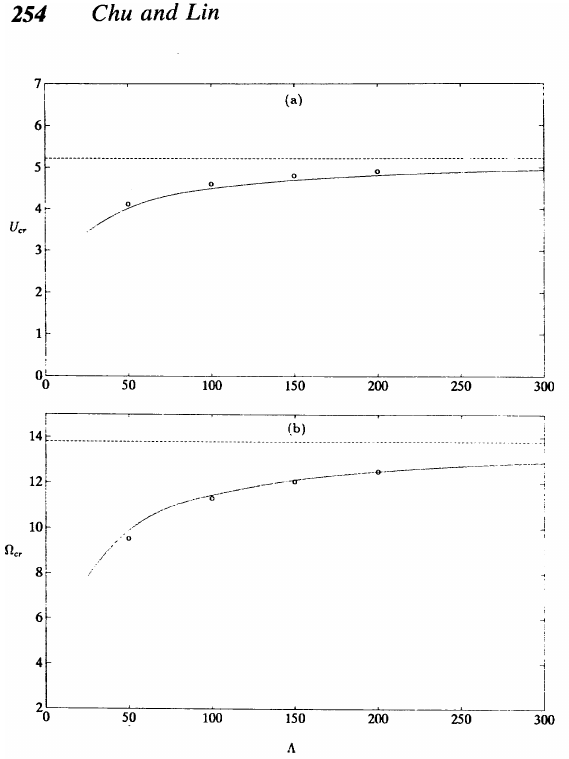
FIGURE 2 Nondimensional (a) critical velocity and (b) the corresponding angular frequency as a function of the slenderness ratio. (---) Bernoulli-Euler ele ment; (-) Timoshenko element (this work); (0) Ti moshenko theory (Pai"doussis et aI.,